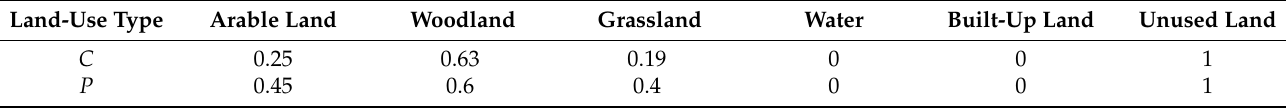
Table 4. The value of C and P of each land-use